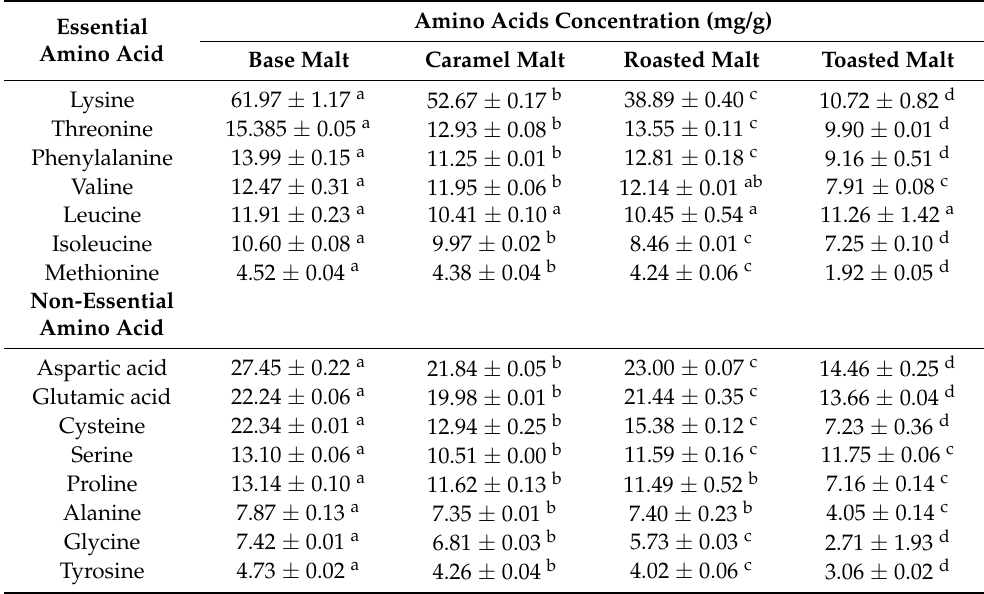
Table 8. Amino acids concentrations of Bambara groundnut speciality malts 1